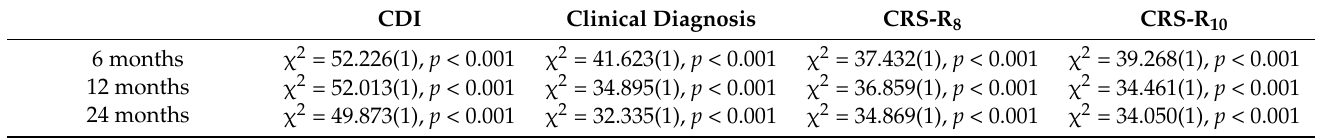
Table 3. Univariate chi-square analysis between CDI, clinical diagnosis, CRS-R 8 , and CRS-R 10